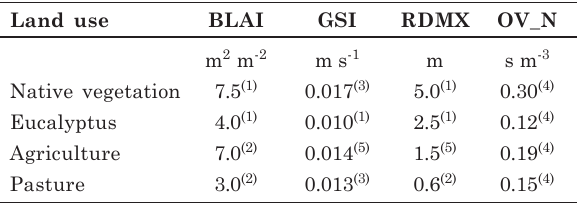
Table 1. Modified vegetation parameters from SWAT database for the hydrologic simulation in the Galo creek